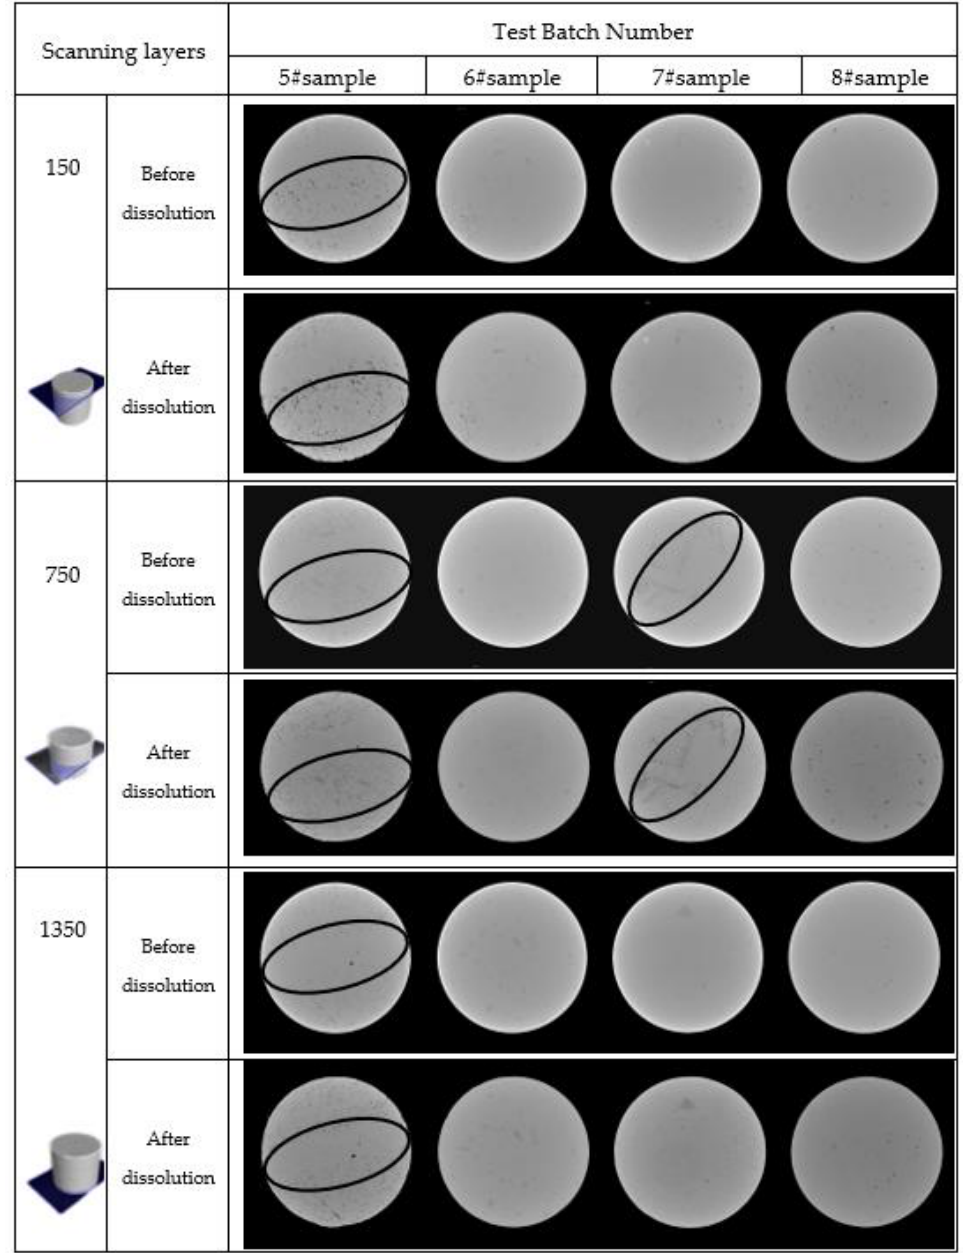
Figure 6. Cross-sectional view of CT scan.